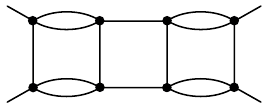
Figure 11: A graph whose Landau curve (more precisely, its leading singularity) can be found using the method described in this section. The Landau curve sits between the blue and red curves in figure 5. Given that it is not α -positive, we do not expect it to be on the physical sheet. In the graph selection procedure, this graph was discarded by identification of a trivial box (see figure